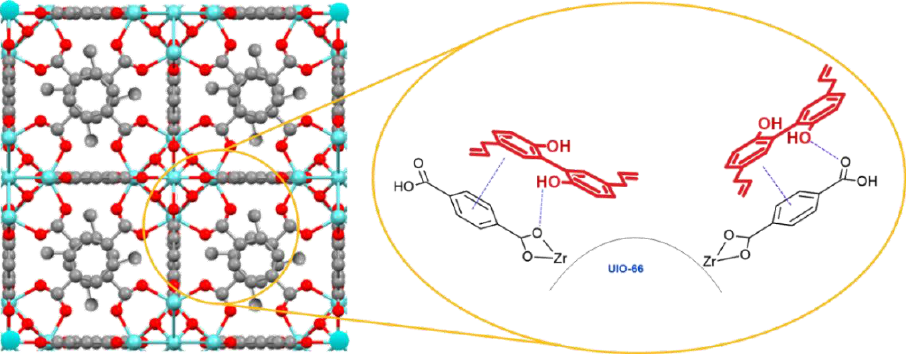
Figure 9. Predicted binding mechanism of magnolol to Uio-66(Zr) [51] showing π–π interaction and hydrogen bonding.